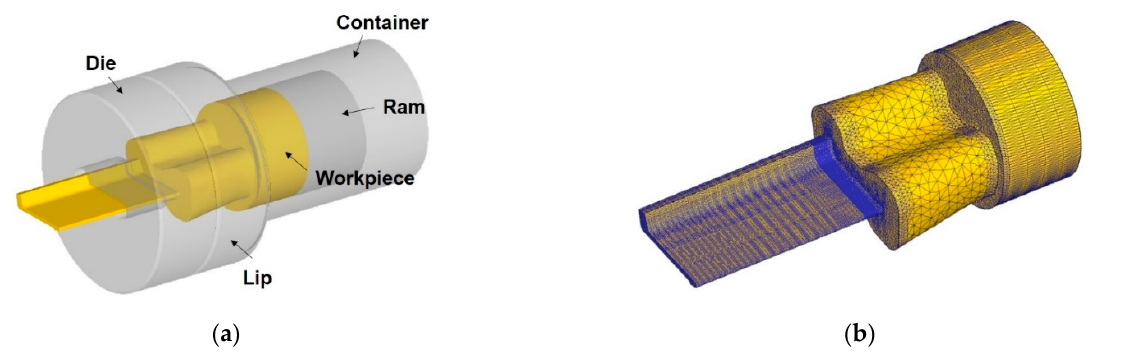
Figure 6. Modeling of the L-shaped sample extrusion for a numerical analysis based on the arbitrary Lagrangian-Eulerian method: ( a ) schematic illustration; and ( b ) finite element discretization of the workpiece.